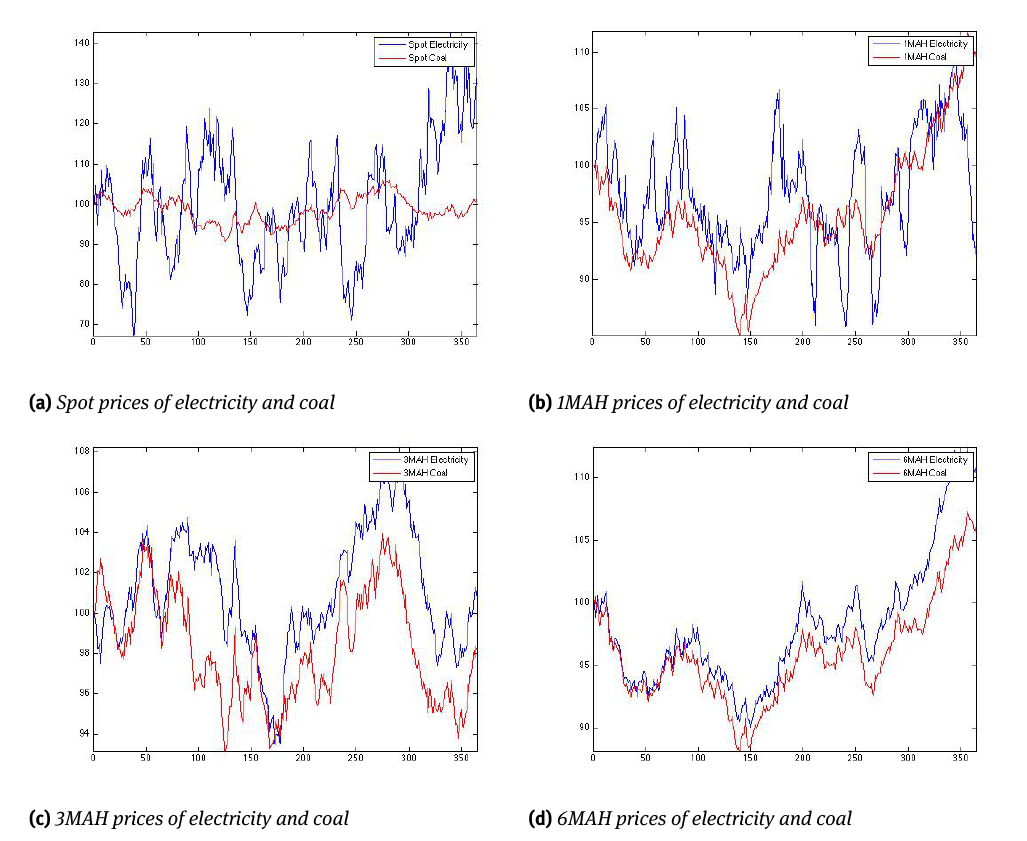
Figure 11: One year trajectory of electricity and coal products in the multi-barrier correlation model with a time step of 1 24 days.